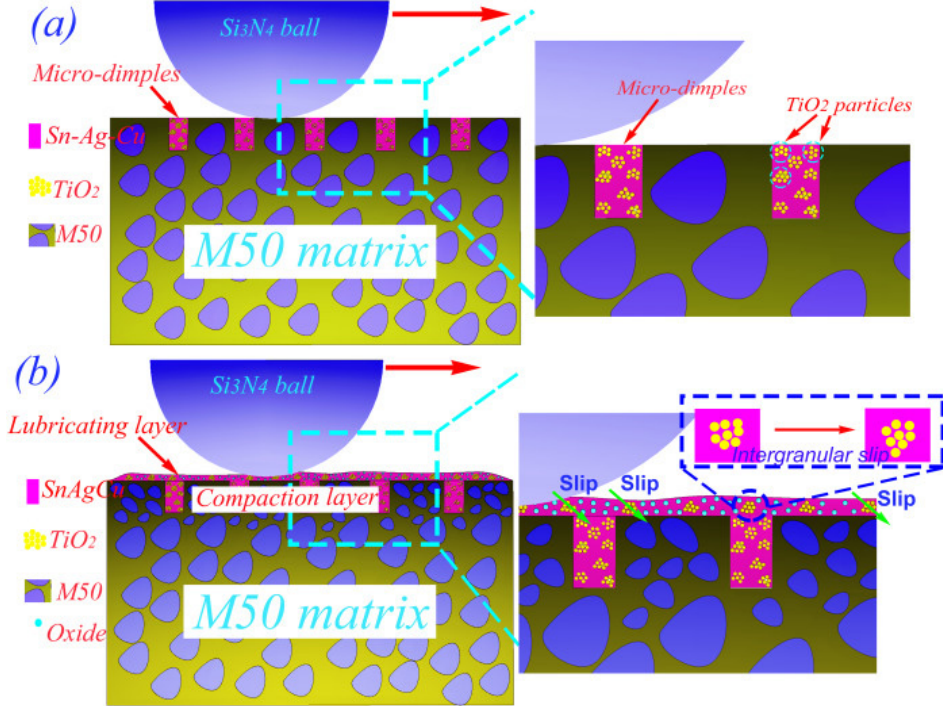
Figure 5. The self-lubrication mechanism of the M50 bearing dispersed with multiple lubricants ( a ) Sn, Ag, Cu/TiO 2 removed from micro-dimples, ( b ) Slip behavior of TiO 2 particles. Reproduced with permission from [65]. Copyright Elsevier, 2021.